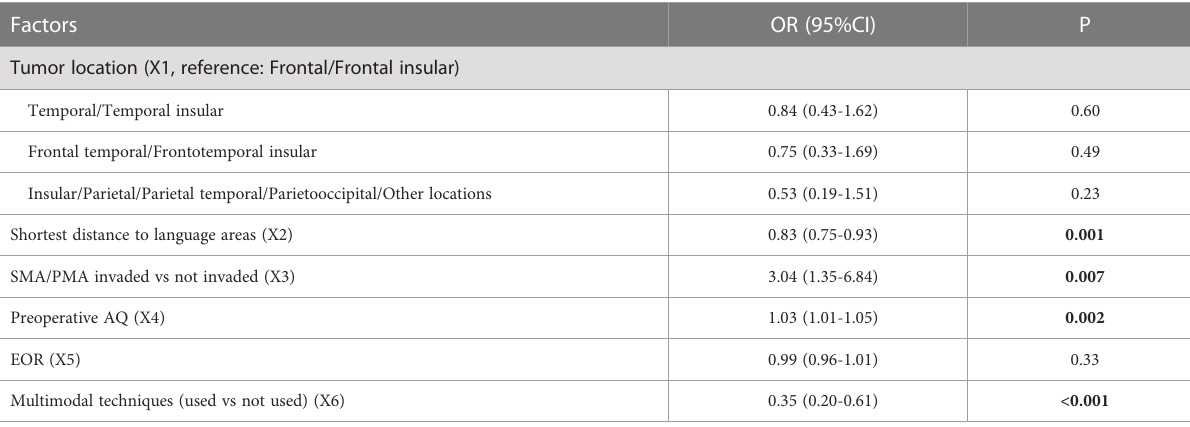
Boldface type indicated statistical signi fi